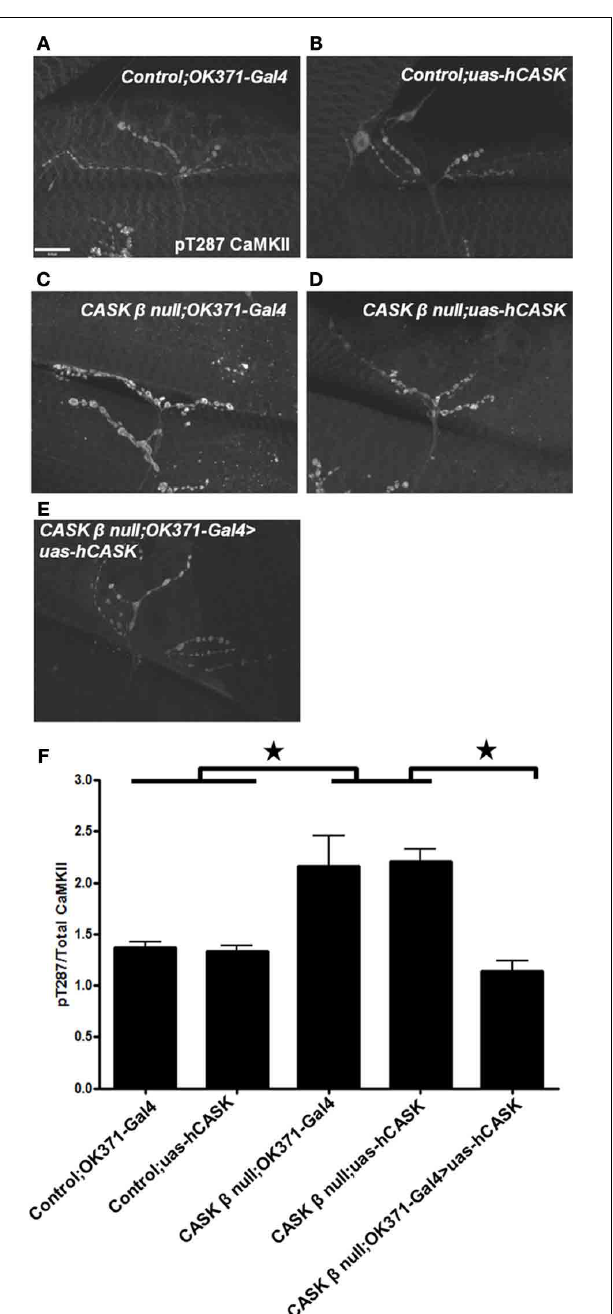
FIGURE 8 | Human CASK expression rescues the effect of CASK β deletion on CaMKII autophosphorylation. Representation images of pT287 CaMKII-stained NMJs from (A) OK371-Gal4/ + control larvae (B) uas-human CASK/ + control larvae (C) CASK β null; OK371-Gal4 mutant larvae (D) CASK β null; uas-human CASK mutant larvae (E) CASK β null; OK371-Gal4 > uas-human CASK rescue larvae. (F) CASK β null; uas-human CASK and CASK β null; OK371-Gal4 mutant larvae had significantly elevated pT287 CaMKII levels compared to uas-human CASK or OK371-Gal4 larvae ( p < 0 . 05). Motor neuron expression of human CASK in a CASK β null background significantly reduced pT287 CaMKII levels to levels that were indistinguishable from wildtype ( p > 0 . 05, n = 6, One Way ANOVA with a Bonferroni post-hoc